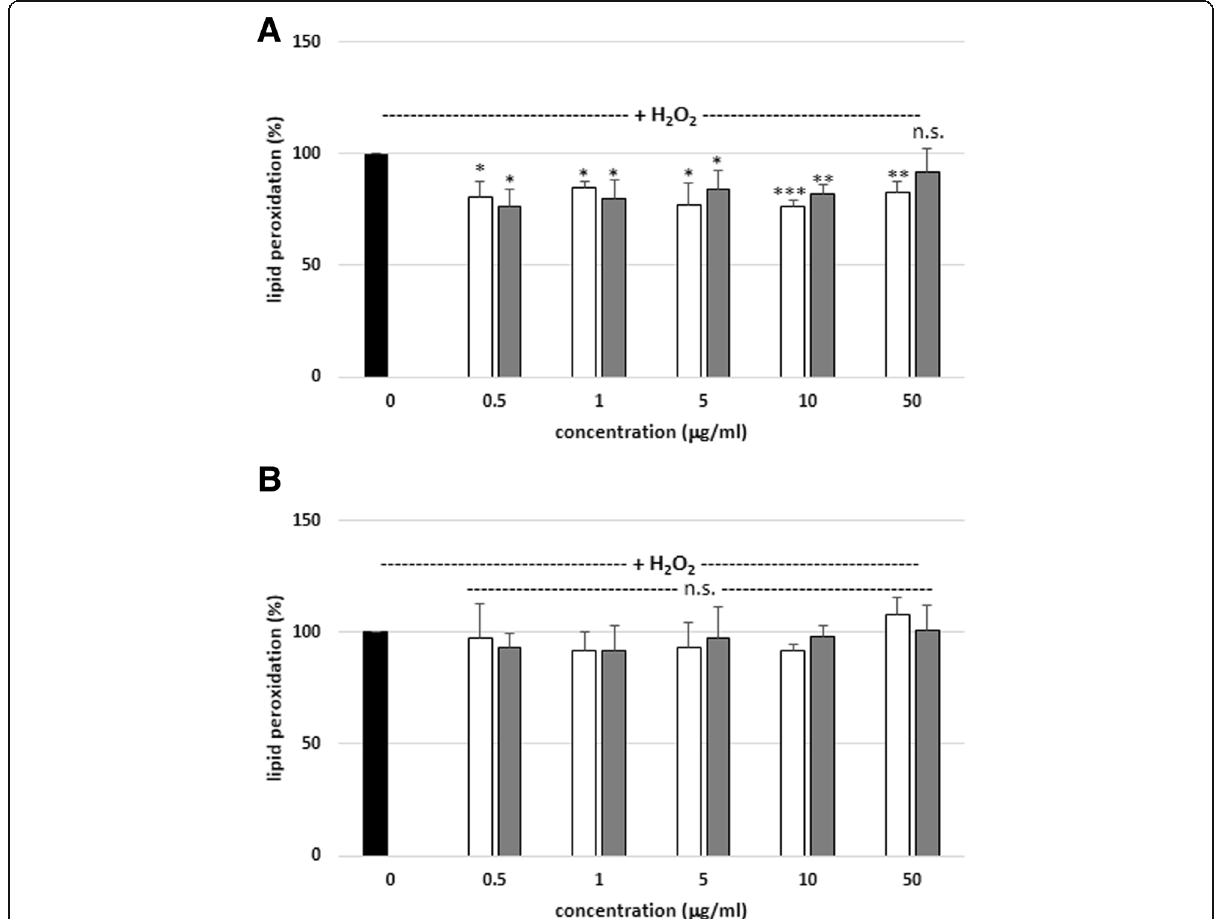
Fig. 1 Effects of SBT twig and leaf extracts (0.5 – 50 μ g/mL; 15 min ( a ) and 60 min ( b )) on plasma lipid peroxidation induced by H 2 O 2 . In these experiments, the TBARS level (marker of lipid peroxidation) in control samples (plasma treated with only H 2 O 2 ) was 0.254 ± 0.046 nmol/mL of plasma. Data represent means ± SD of 5 – 10. The effect of five different concentrations of two tested extracts (0.5, 1, 5, 10 and 50 μ g/mL; for 15 min) was statistically significant (* p < 0.05, ** p < 0.005; *** p < 0.001) in comparison to control. The effect of five different concentrations of two tested extracts (0.5, 1, 5, 10 and 50 μ g/mL; for 60 min) was not statistically significant ( p > 0.05 (n.s.)) in comparison to control. The effects were not statistically significant: SBT twig extract-treated plasma vs. SBT leaf extract-treated plasma ( p > 0.05 (n.s.); for all tested concentrations- 0.5 - 50 μ g/mL; for 15 and 60 min). black diagram – control, white diagram – twig, grey diagram -